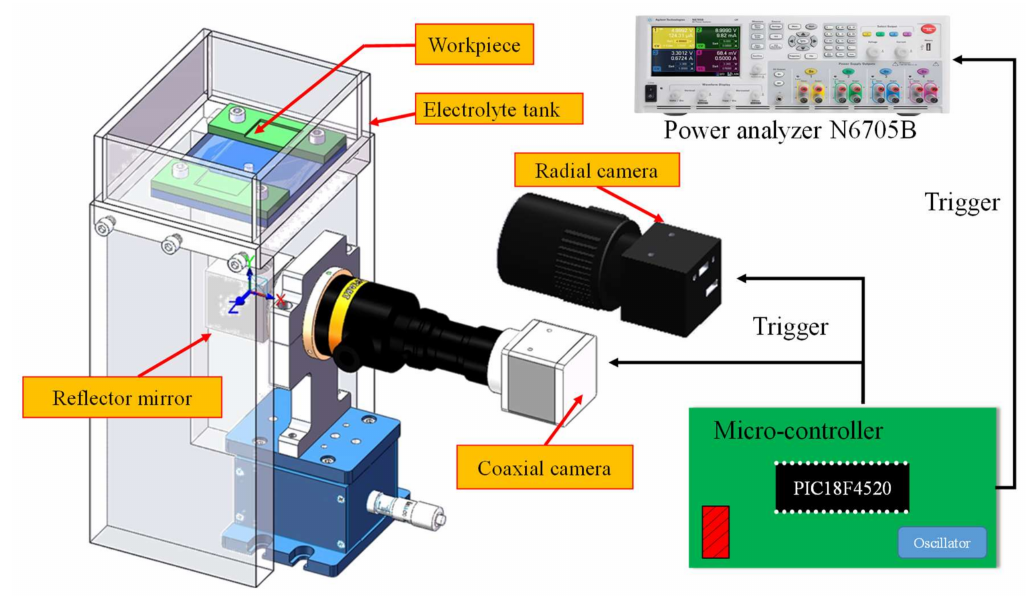
Figure 2. The schematic diagram of the spark-assisted chemical engraving (SACE) experimental setup.